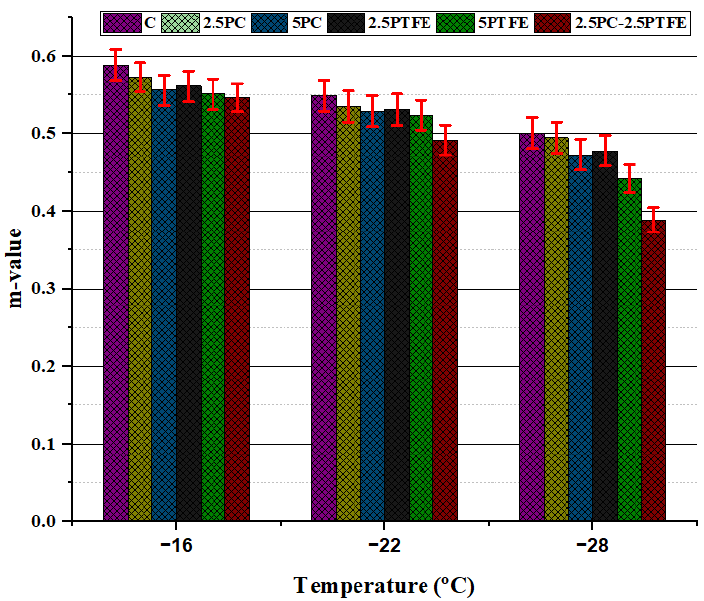
Figure 13. Effects of PC and PTFE on the m-value of PG 70.